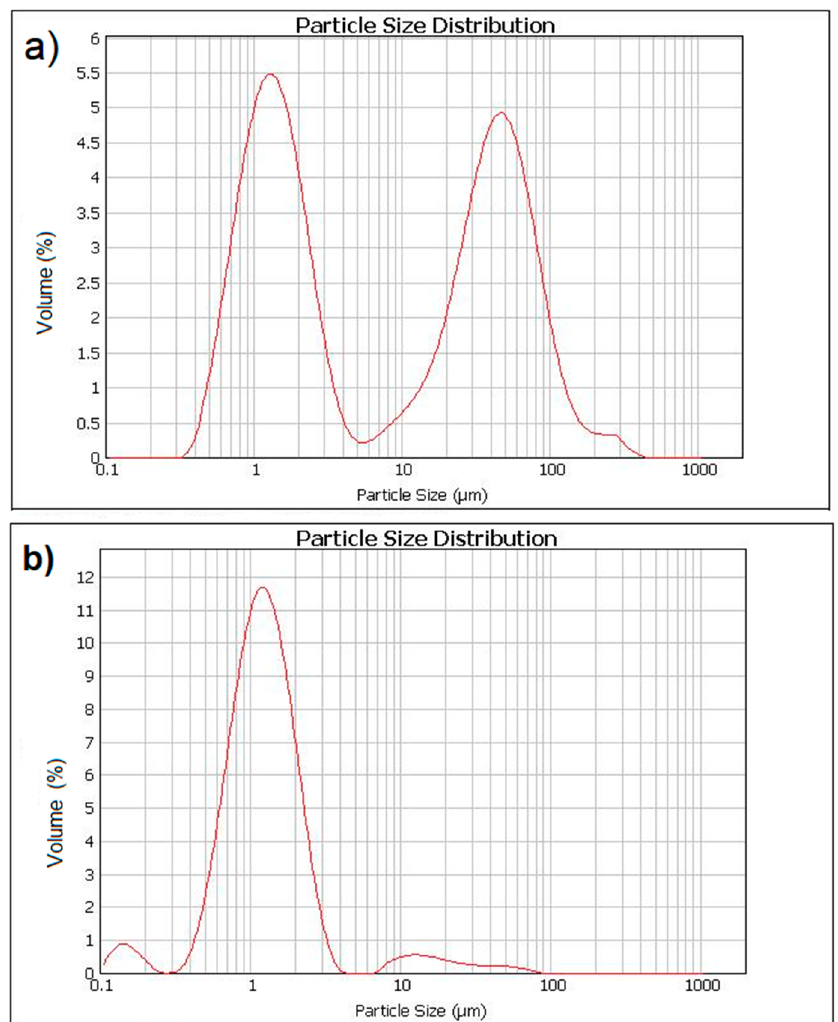
Figure 8. Influence of the ultrasonic dispersion (sonication) on the granulometry of Fe 3 O 4 nanoparticles in the solution of water and superplasticizer based on polycarboxylic ether PCE: ( a ) without sonication and ( b ) after sonication for 1 min.